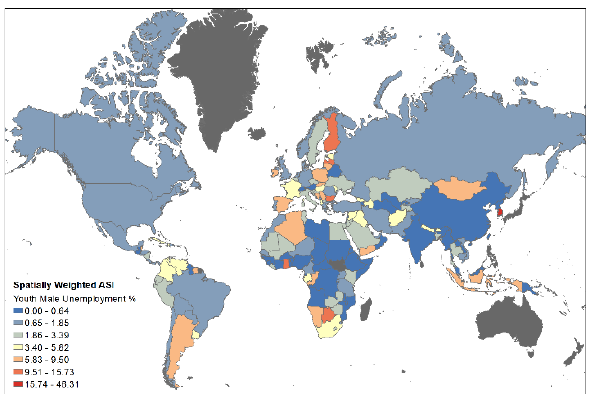
Figure 5. Spatially Weighted Attribute Stability Index ( stable in an unstable neighbourhood, is Belarus. Figure 6 shows the youth male unemployment trends for Belarus and all its neighbours.